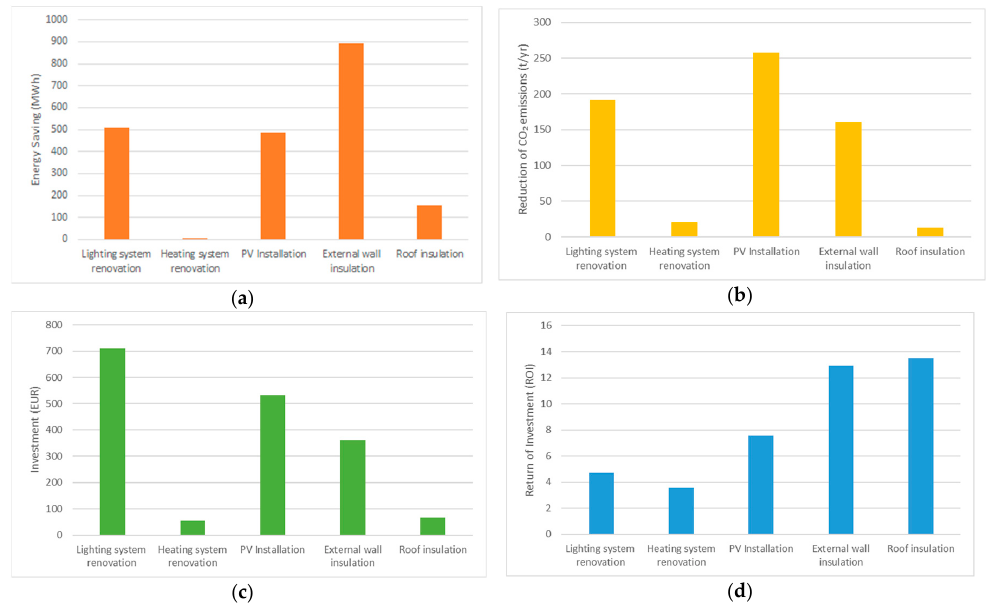
Figure 5. Total amount of ( a ) Energy Savings, ( b ) CO 2 emission reduction, ( c ) ROI and ( d ) Investment cost per typology of intervention in the selected MPBs.